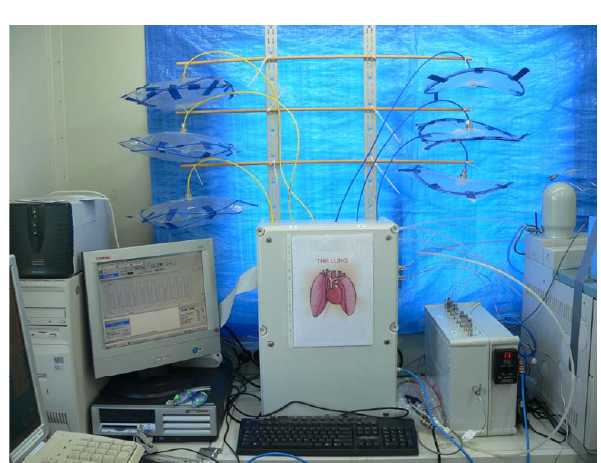
Figure 3. 2 Fig. 3. “Lung-GC system” set-up in mobile laboratory trailer. The “Lung” is in the centre of the picture and corresponds to the shaded box in Fig. 1. The set of bags on the left (Cluster B) are being filled while those on the right (Cluster A) are being evacuated. Ribs on the bags help to keep them flat. To the right of The Lung is the Valco stream selection valve (mounted inside the box) and further to the right the GC can just be seen. To the left of the Lung is the GC control and acquisition PC and the LabVIEWPC controlling the entire